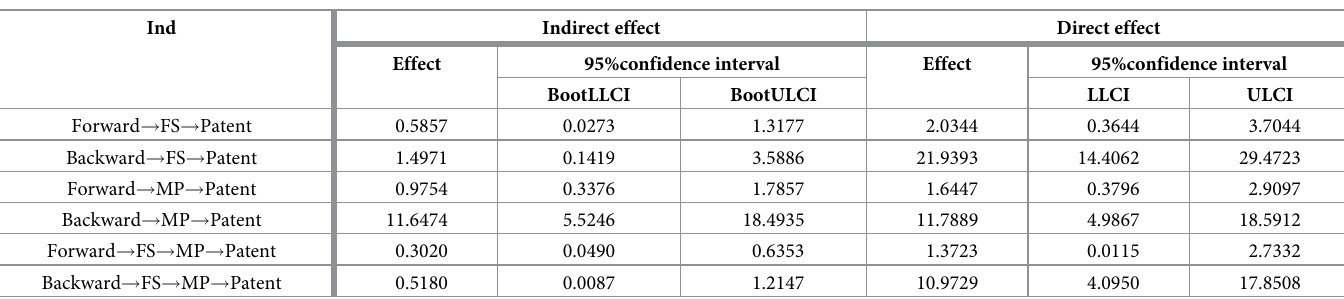
Table 10. Robustness